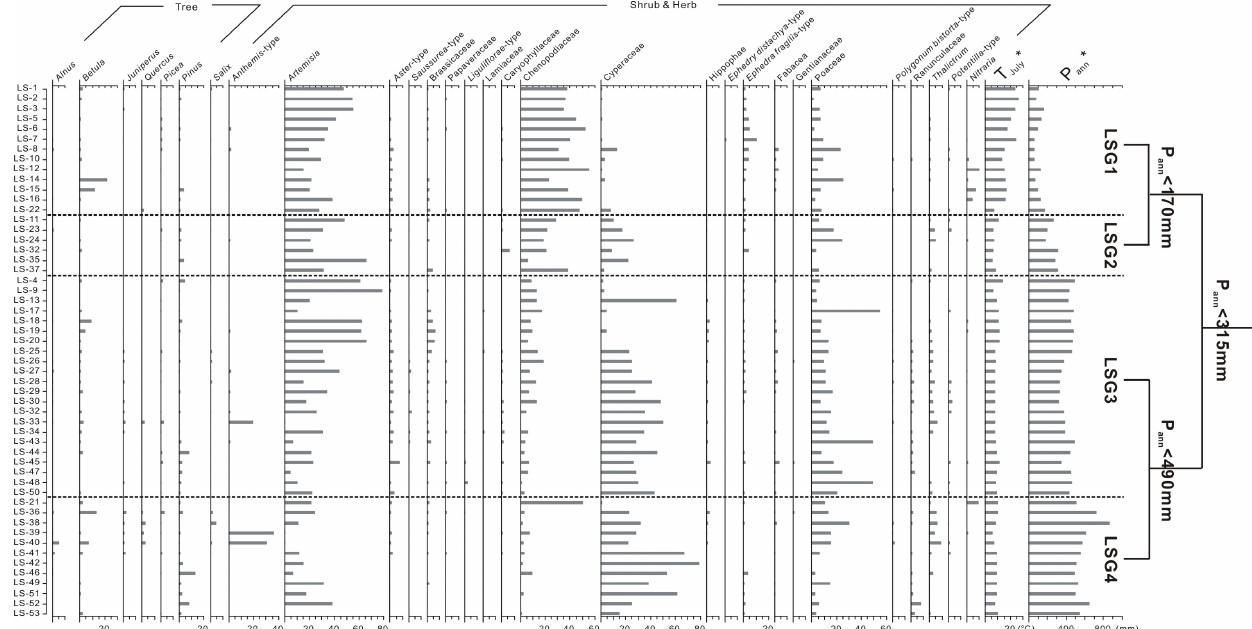
Fig. 2. Pollen spectra of surface sediment samples from large lakes together with the associated inverse-distance-weighted climate data ( P ∗ ann and T ∗ ). A Multivariate Regression Tree (MRT) plot for surface sediment pollen data from the 53 large lakes, with the group classifications July (LSG 1–4), is shown to the right of the pollen